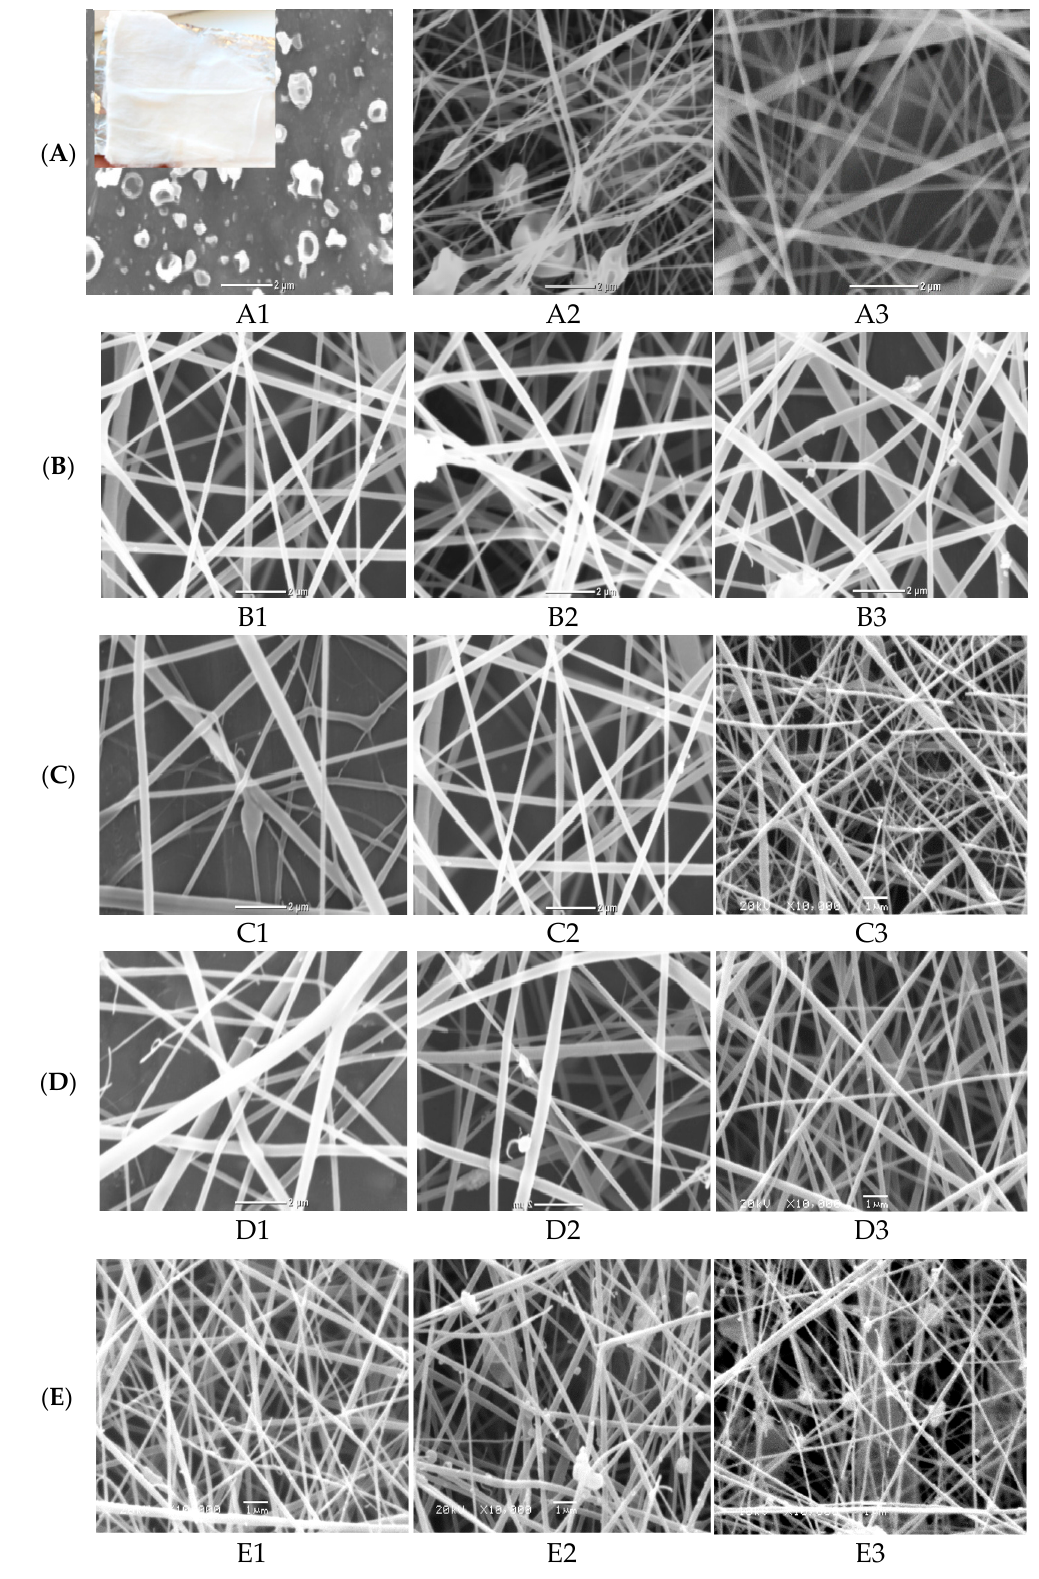
Figure 1. SEM micrographs of electrospinning processing parameters on fabricated ZnO polymeric composite nanofiber: ( A ) Cellulose acetate concentration (8–16 wt%), ( B ) solution flow rate (0.2–1 mL/h), ( C ) applied voltage (10–30 KV), ( D ) distance between needle tip and collector (8–18 cm) and ( E ) amount of loaded ZnO NPs as a filler (0.02–0.1 wt%).